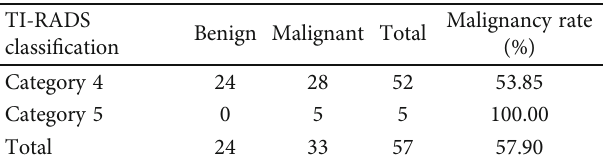
Table 4: Biopsy results of thyroid nodules classi fi ed as TI-RADS 4- 5.